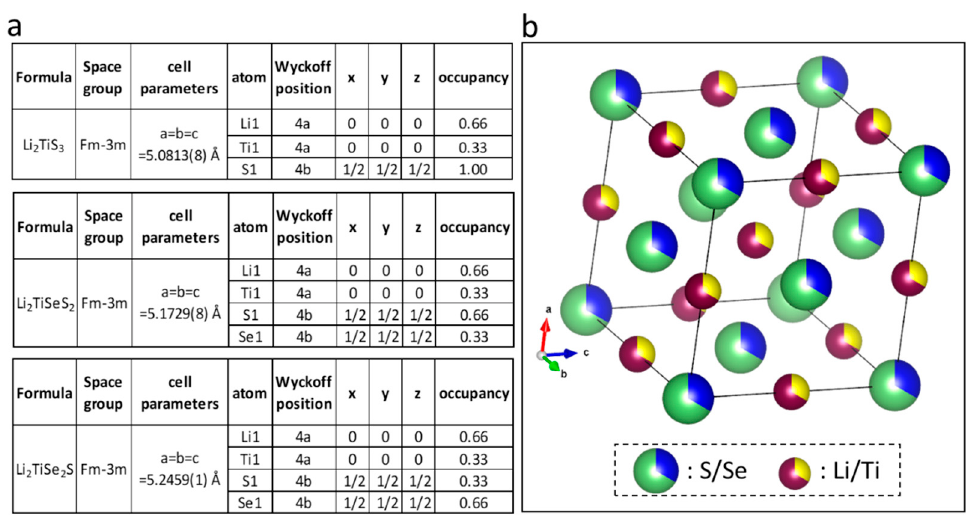
Figure 2. ( a ) Refined parameters of Li 2 TiSe x S 3 − x (0 ≤ x ≤ 2) materials and ( b ) Li 2 TiSeS 2 structure.